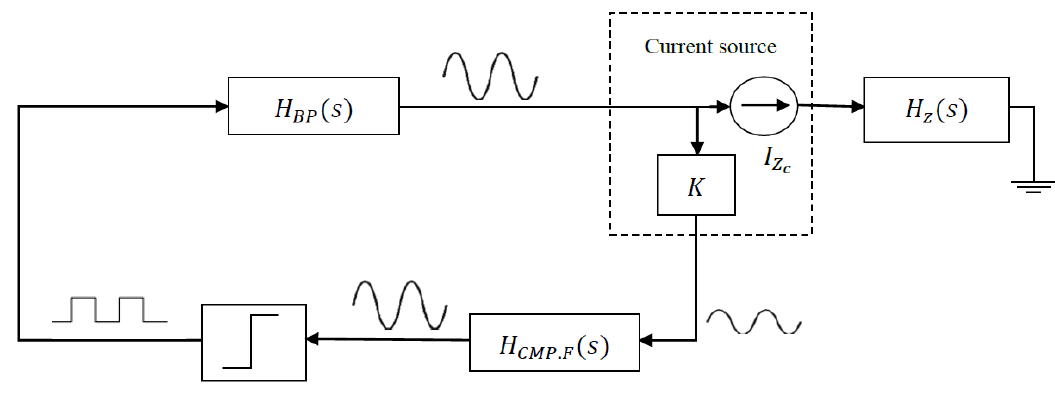
Figure 3. Oscillation-based test (OBT) block diagram.